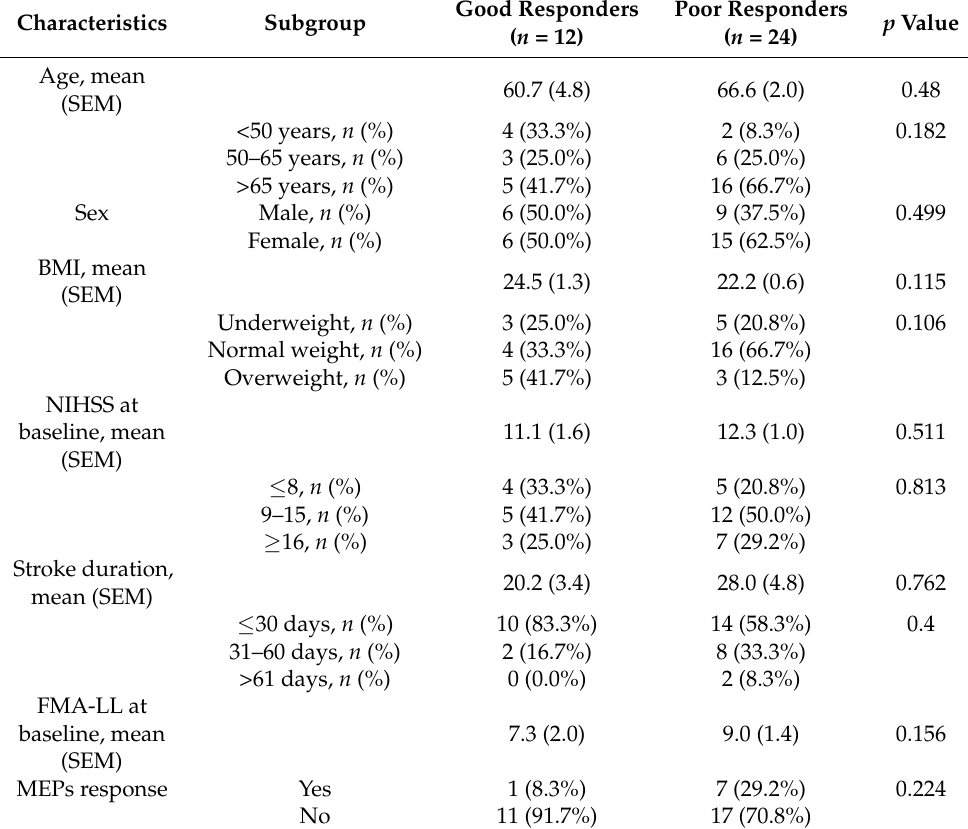
Table 1. Baseline demographics and clinical characteristics of good responders and poor responders among stroke patients treated with mesenchymal stem cells.